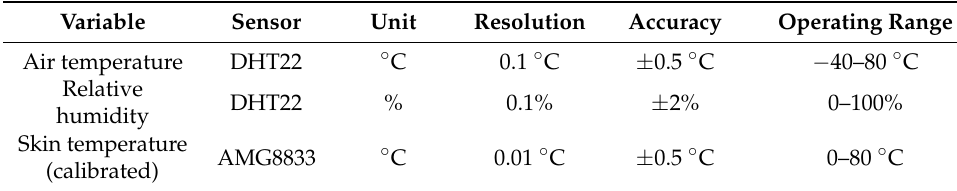
Table 1. Components in the non-intrusive sensing